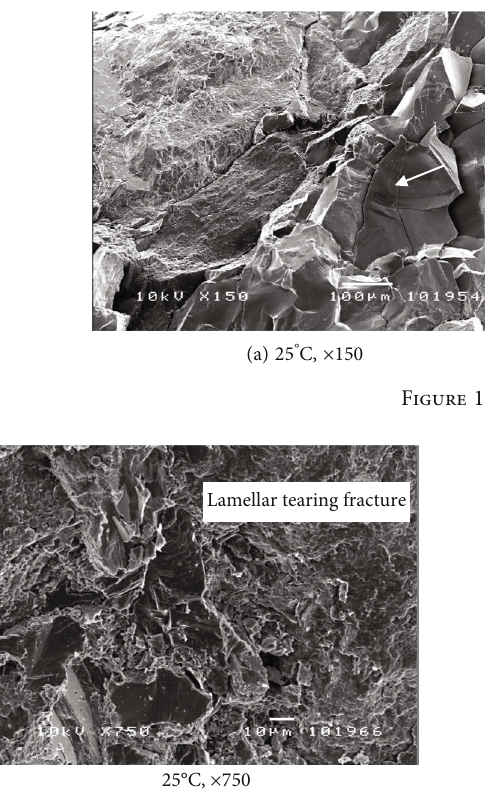
Figure 16: Parallel slip line